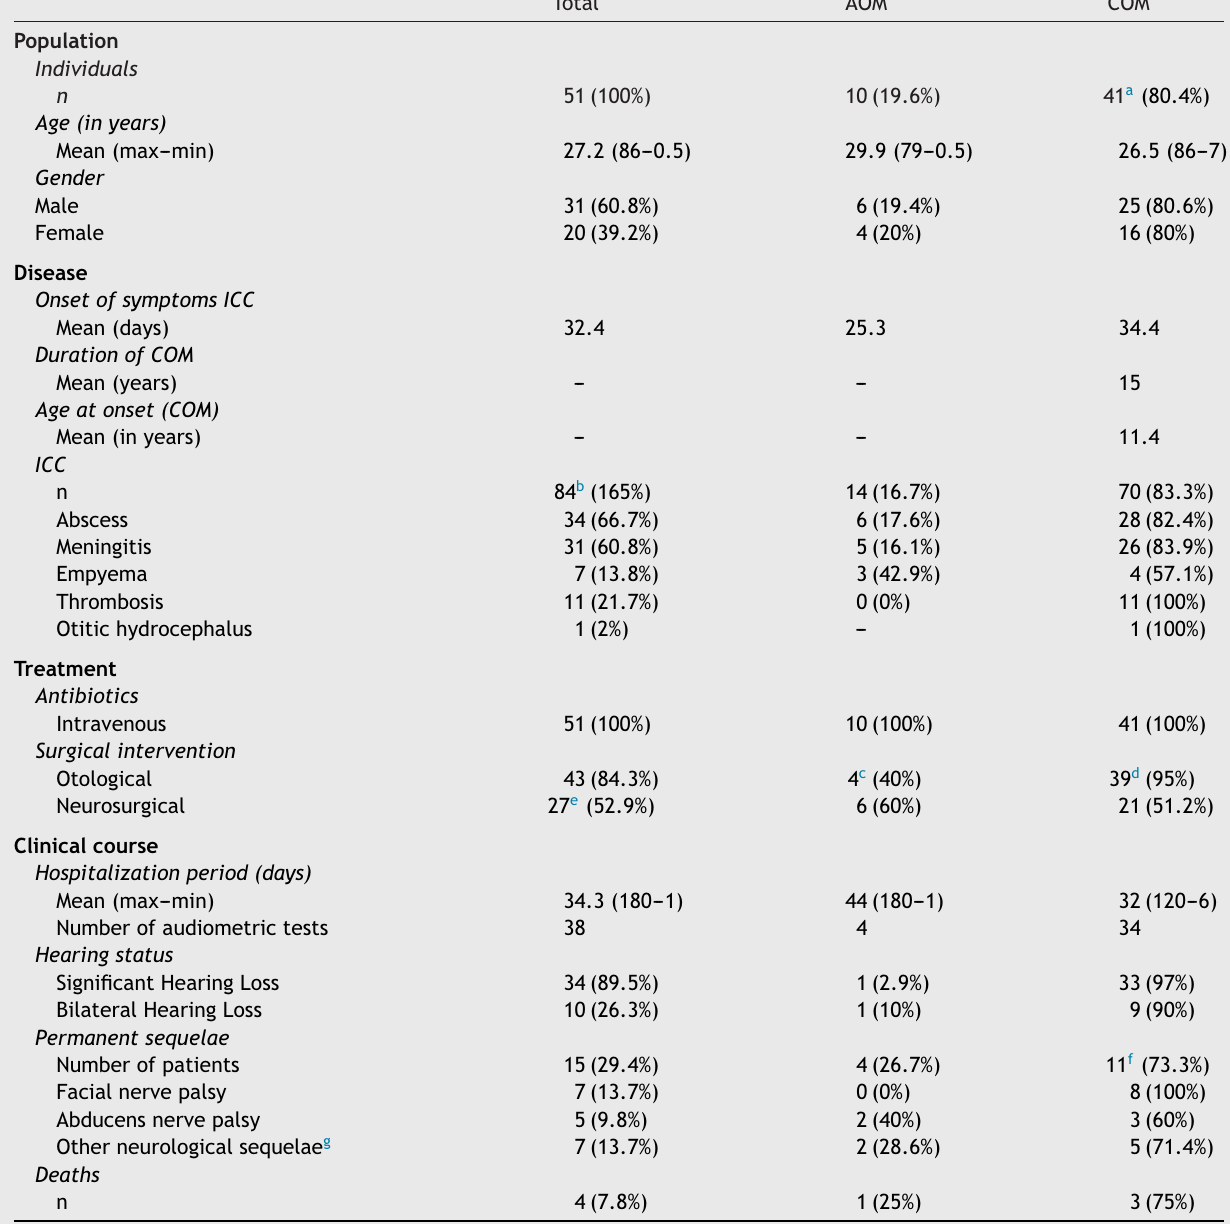
Table 2 Summary of current study data regarding cases of intracranial complication secondary to otitis